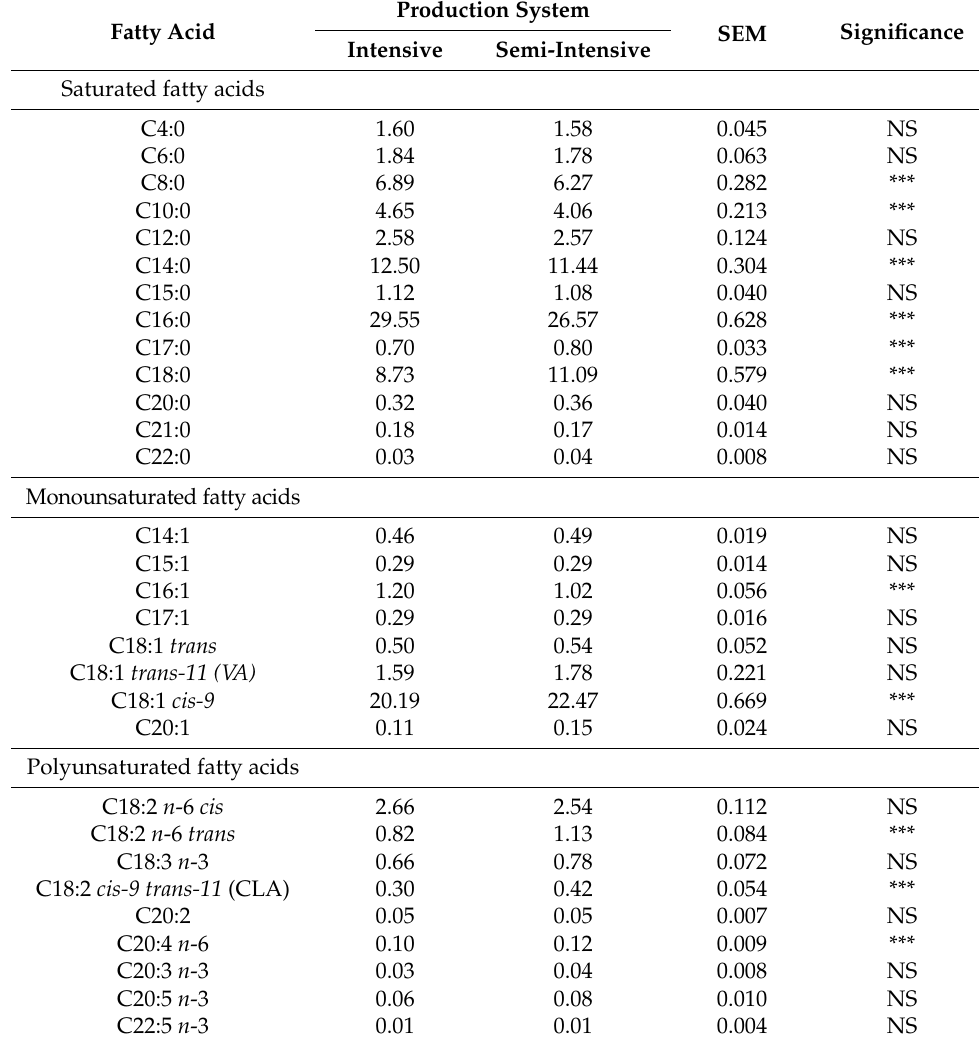
Table 3. Effect of the production system on sheep milk fatty acid composition (% of total identified fatty acids).